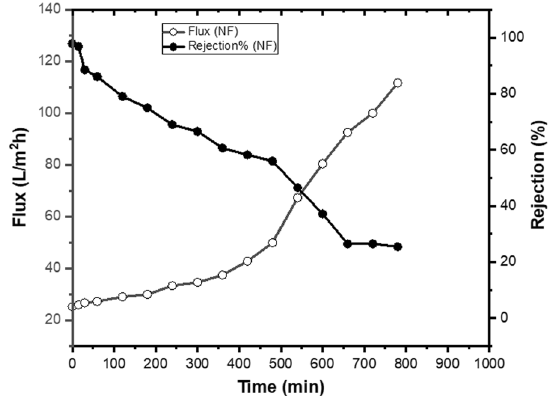
Fig. 10 Effect of NaOCl reaction time on permeate TDS of nanofil- tration